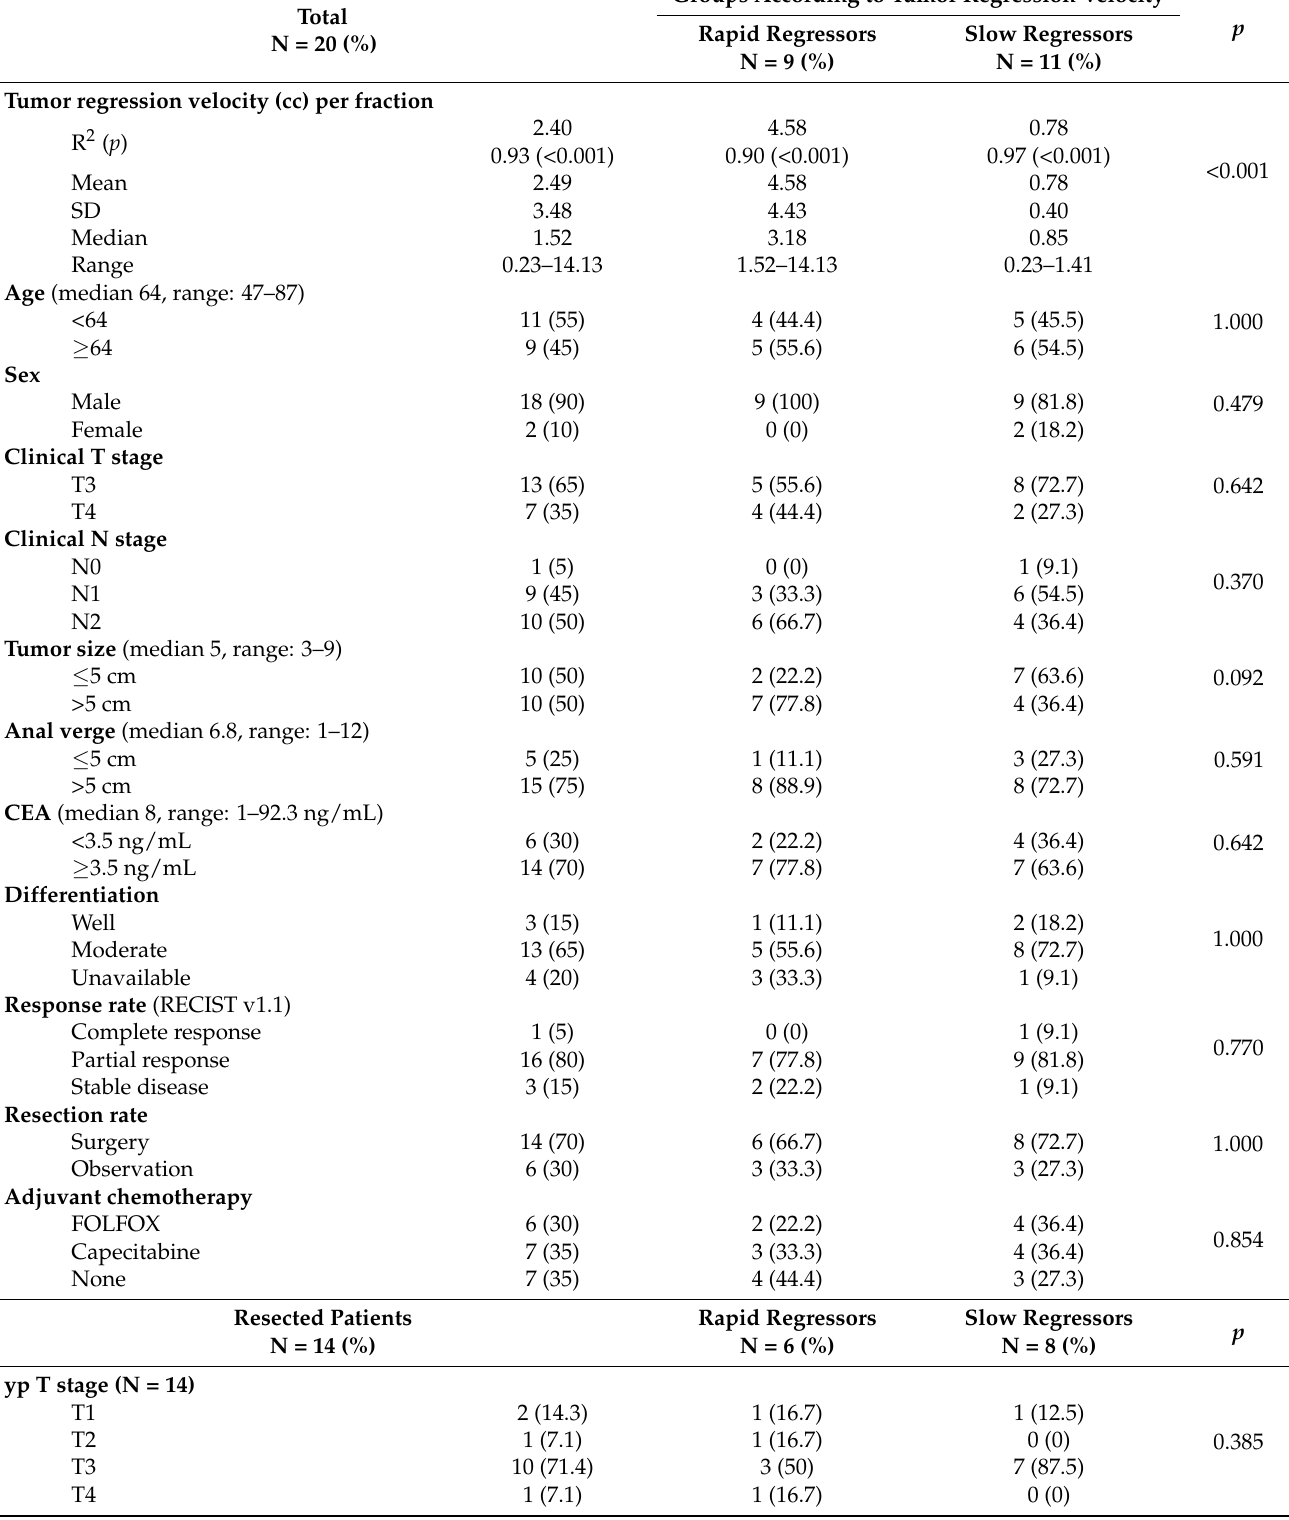
Table 1. Tumor, patient, and treatment characteristics of 20 patients who underwent chemoradiotherapy. Groups According to Tumor Regression Total